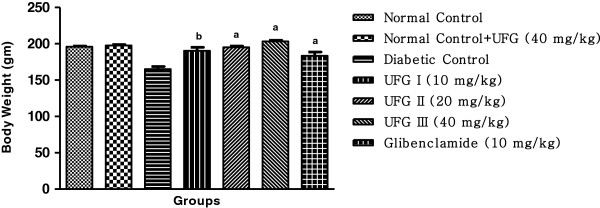
Effect of umbelliferone β-D-galactopyranoside on body weight at different concentrations on STZ induced diabetic rats, compared to diabetic control group rats; values are mean ± SEM; n = 6;
c
P < 0.05;
b
P < 0.01;
a
P < 0.001; P > 0.05 is considered as non-significant (ns).